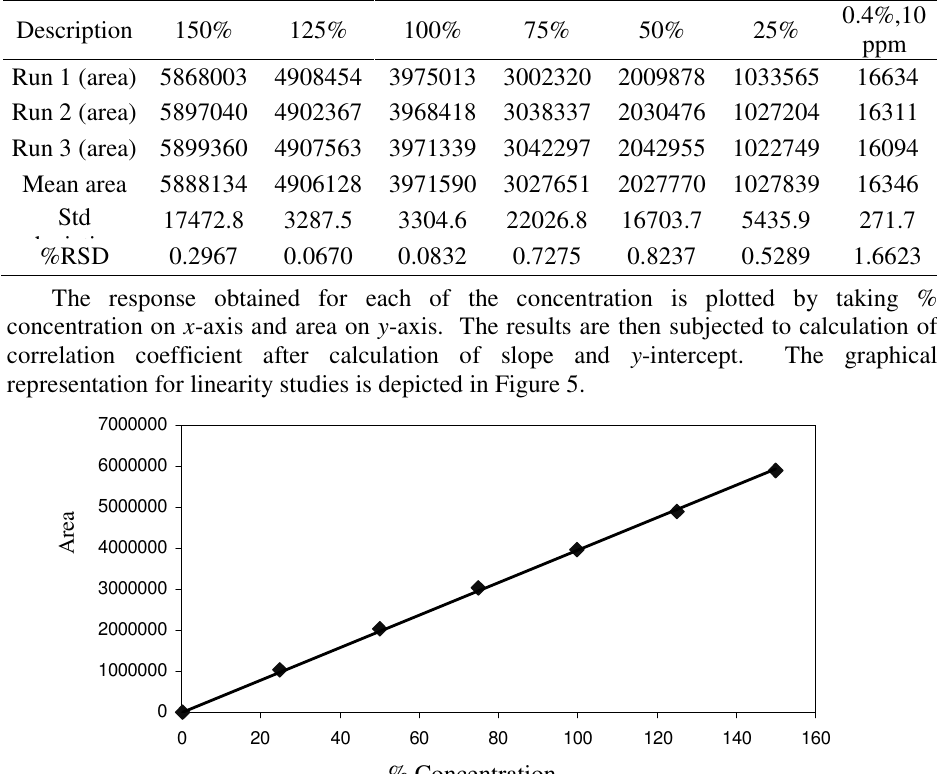
Figure 5. Ibutilide fumarate linearity studies plot %